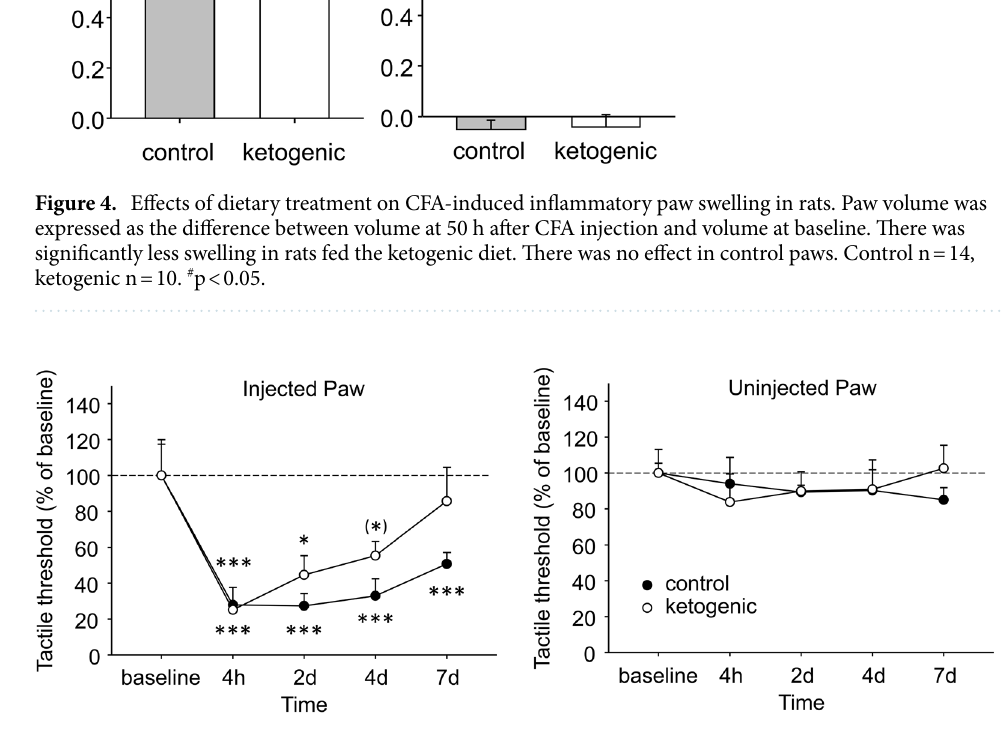
Figure 5. Effects of CFA and diet treatment on tactile allodynia in mouse assessed by electronic von Frey probe. Injected paws became hypersensitive after CFA injection, but the rate of recovery differed in the groups. Control diet-fed mice were still strongly hypersensitive at the last examined timepoint, whereas a gradual and complete recovery occurred in ketogenic diet-fed mice. There were no effects in the uninjected paw. Control n = 6,